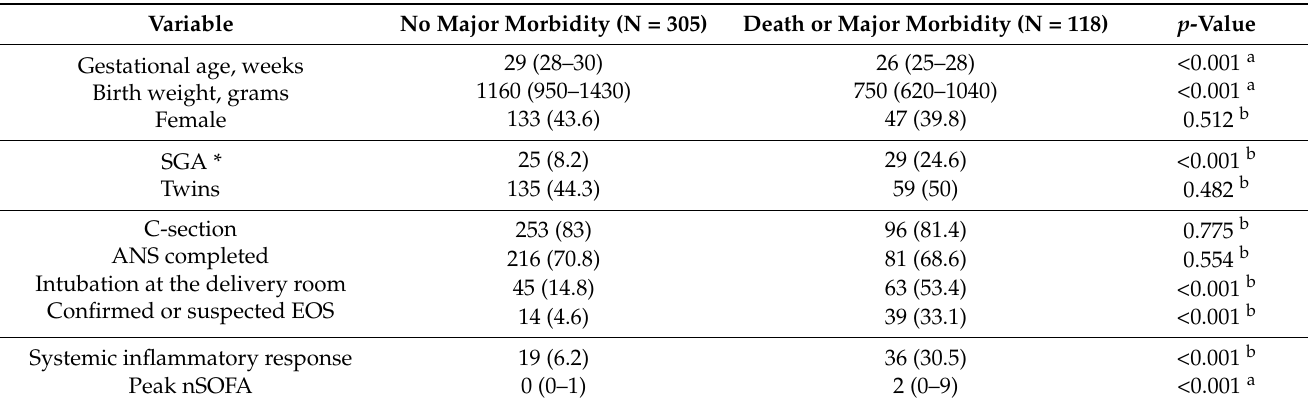
Table 2. Demographic data of the study population according to hospital outcome. Continuous data are presented as median and interquartile range (IQR), categorical variables are presented as number (percentage).